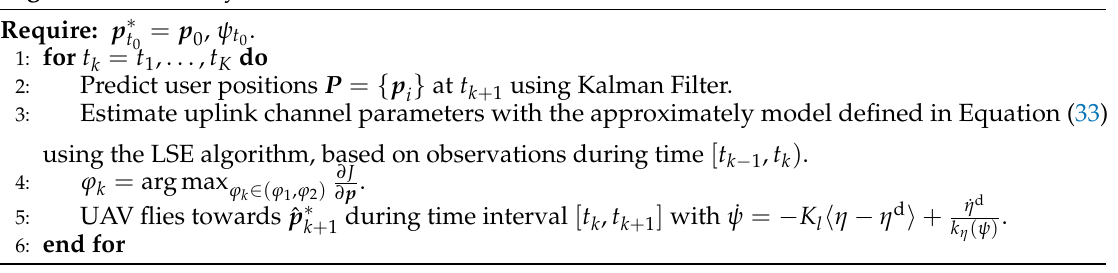
Algorithm 1 Mobility Control method for end-to-end